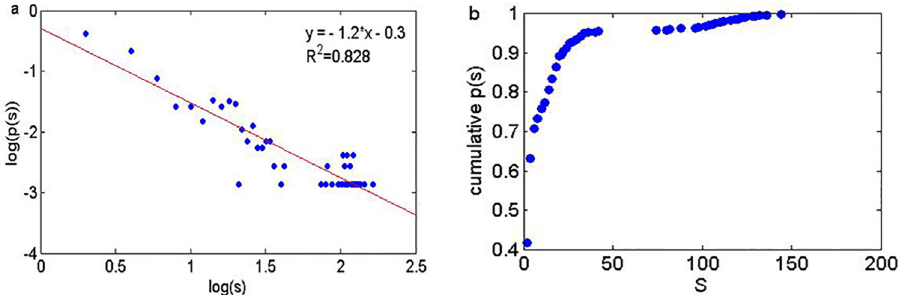
Fig 4. The strength degree distribution in the double logarithmic coordinates and cumulative strength distribution of the SMCOP. (a) The strength distribution in the double logarithmic coordinates of SMCOP. (b) Cumulative strength distribution of